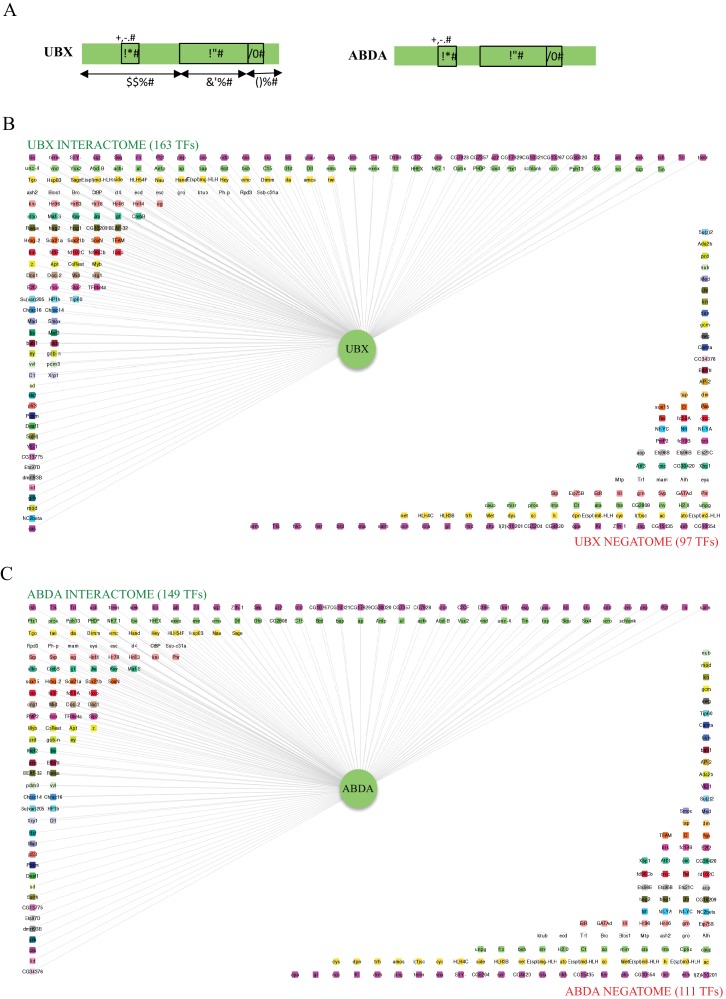
Interactomes and negatomes of Ubx and AbdA with the 260 tested TFs.(A) Schematic representation of Ubx and AbdA. The homeodomain (HD), hexapeptide (HX) and UbdA (UA) motifs are indicated, as well as the percentage of identity of Ubx with AbdA along the corresponding regions. (B) Representation of the interactome (positive interactions) and negatome (negative interactions) of Ubx. (C) Representation of the interactome and negatome of AbdA. Compared to the negatome, HD-containing TFs (green boxes) are more enriched in each interactome. Color code is as in Figure 4 (for most represented TF families: Zinc fingers C2H2, Zf_C2H2: fuchsia; homeodomain, HD: light green; basic helix-loop-helix, bHLH: light orange; no DNA-binding domain, no DBD: white; zinc fingers GATA, Zf_GATA: pink; basic leucine zipper, bZIP: green). Networks are represented using Cytoscape 3.6 (Shannon et al., 2003).